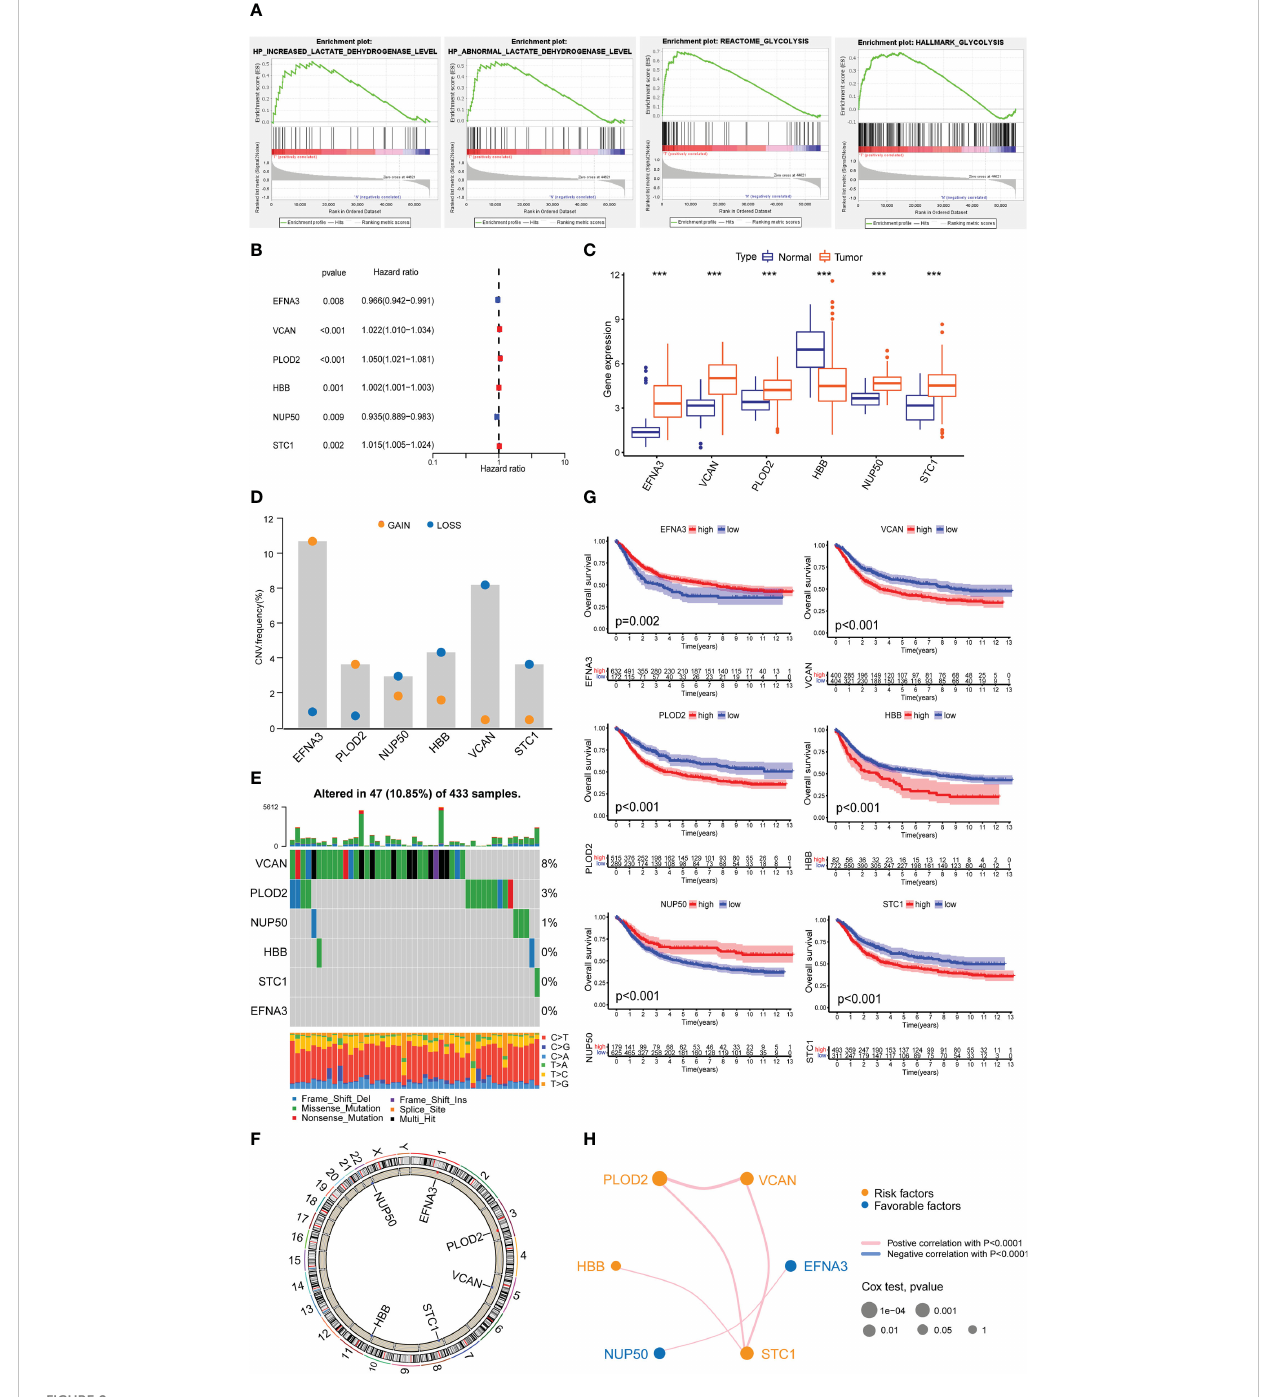
FIGURE 2 Expression of lactylation-related genes in GC. (A) Highly expressed GSEA pathway in GC tissues. (B) Univariate Cox analysis of lactylation-related genes. (C) Expression of lactylation-related genes in GC tissues and normal gastric tissues. ***p<0.001. (D) Diagram of the copy number frequencies of lactylation-related genes. (E) Waterfall plot of the mutation frequencies of lactylation-related genes. (F) Circle plot of the copy numbers of lactylation-related genes. (G) Overall survival rate of lactylation-related gene patient groups. (H) Prognostic network of lactylation-related